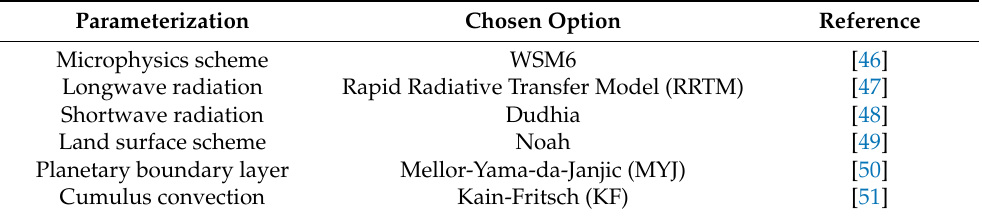
Table 1. Details of the parameterizations used in the assimilation